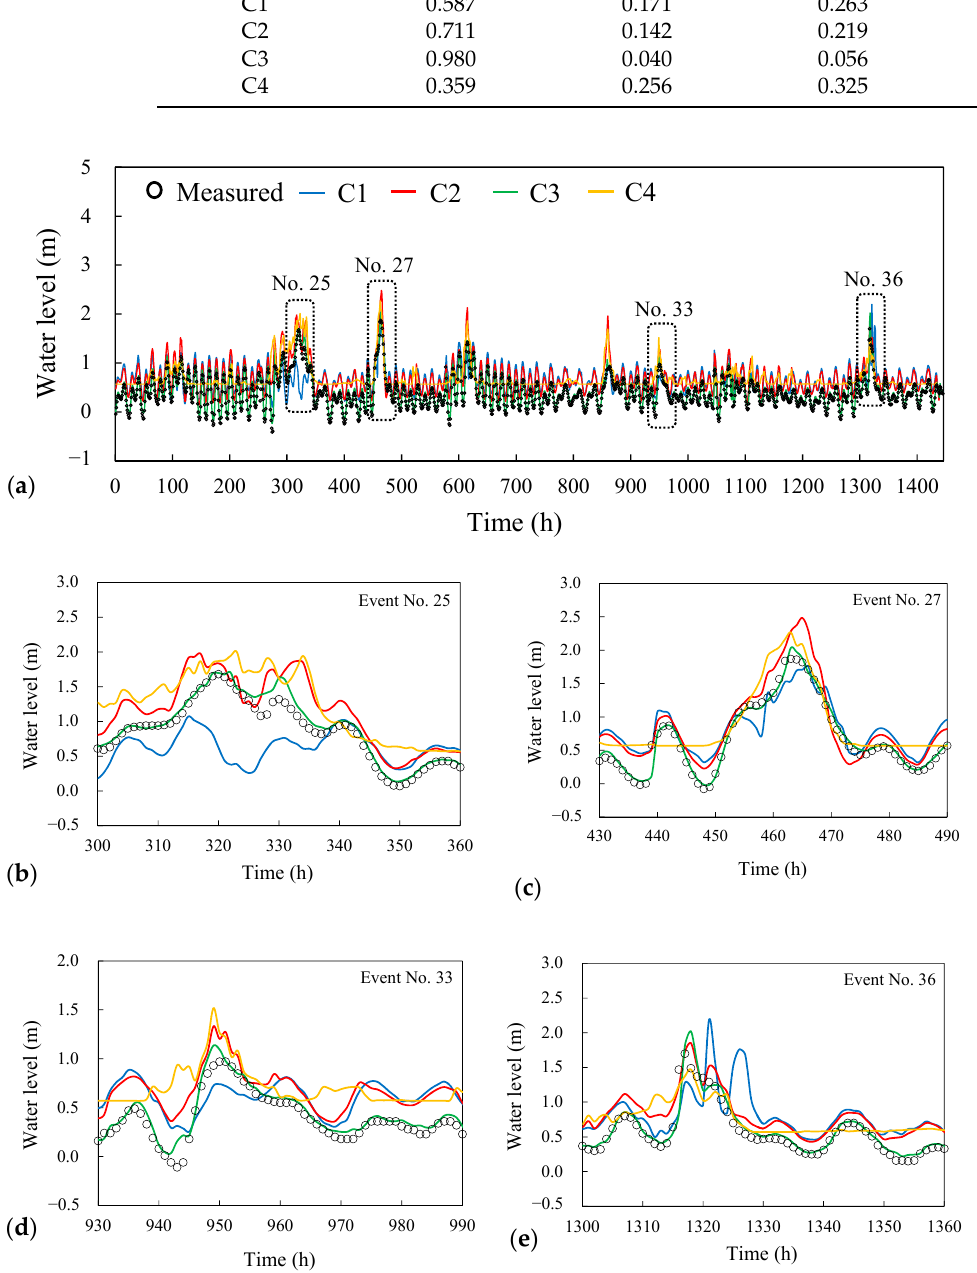
Figure 6. The comparisons of the simulated river stage with the measured one at Kavalan station using SVR with four input combinations for ( a ) all test dataset and ( b – e ) four selected